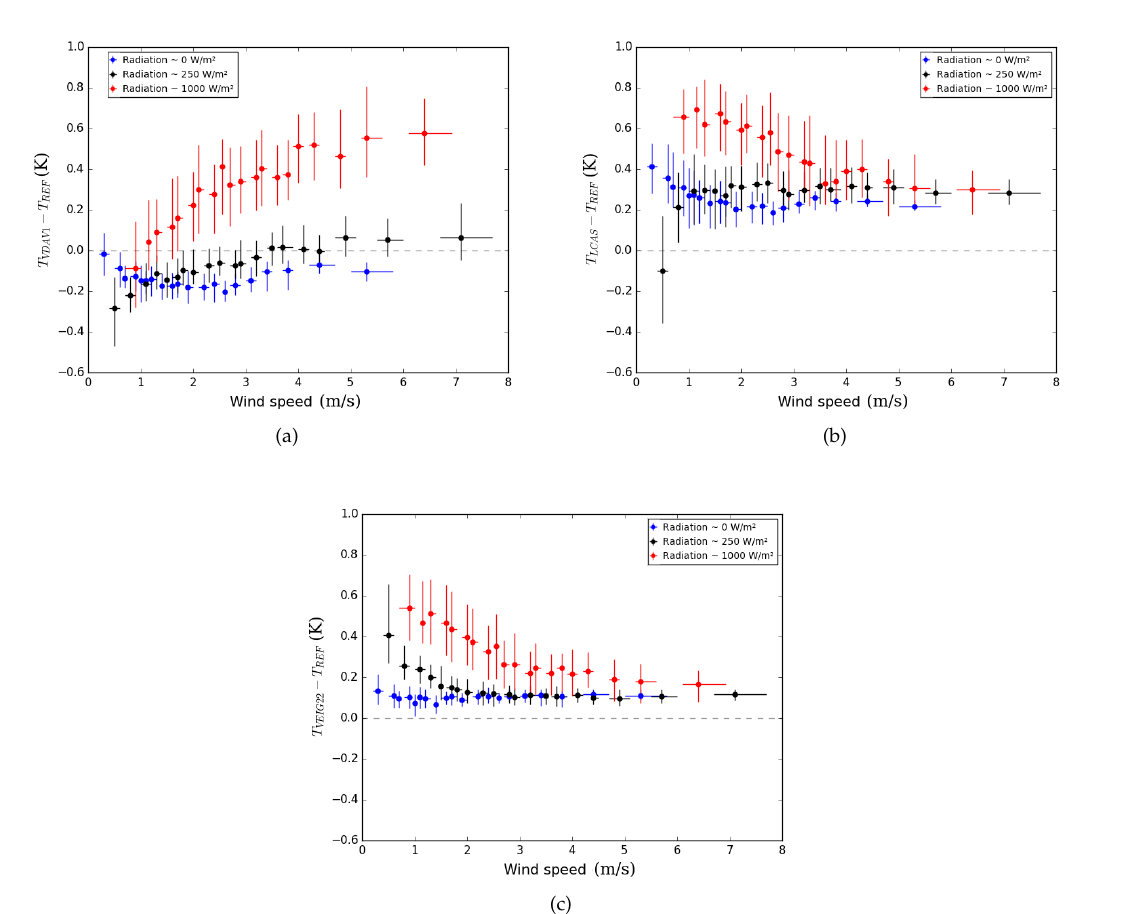
Figure 4. Temperature difference under different wind speed and short-wave radiation values between ( a ) artificially ventilated shelter VDAV1 and reference shelter SDAV, ( b ) LCAS and SDAV and ( c ) hybrid shelter VEIG and SDAV. Please note that each dot/error bars represents the median/quartiles values of a 5 percentile interval of wind speed.